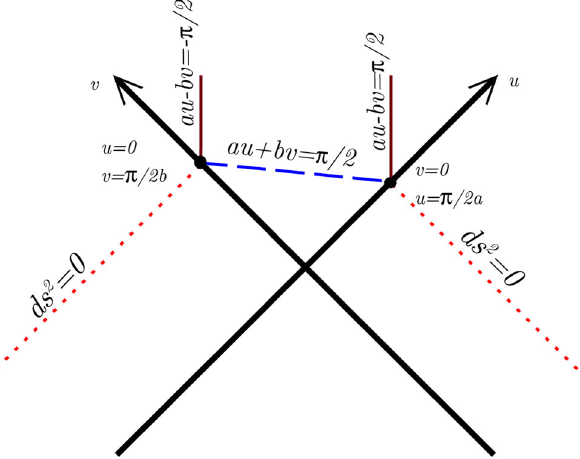
Fig. 2 The singularity structure in the spacetime of colliding waves. π π The surface au + b v = and au + b v = ± are respectively the 2 2 spacelike and timelike singularities. The null singularities are denoted by heavy dots on the light cone. Extension of these points to the incom- ing regions give vanishing line element. This is due to the conformal